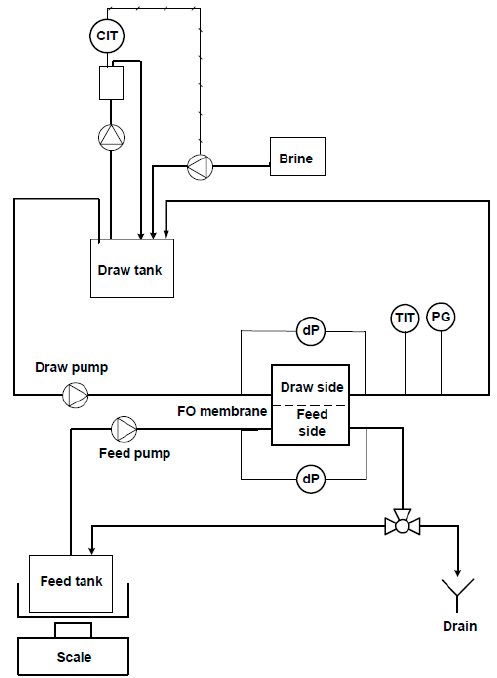
Figure 2. Simplified flow diagram for FO experiments performed in batch mode.